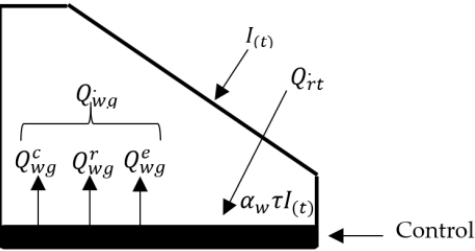
Figure 5. Energy transport mechanisms in a single-slope solar still. The figure shows the forms of heat loss from water to glass where steam condensation occurs.